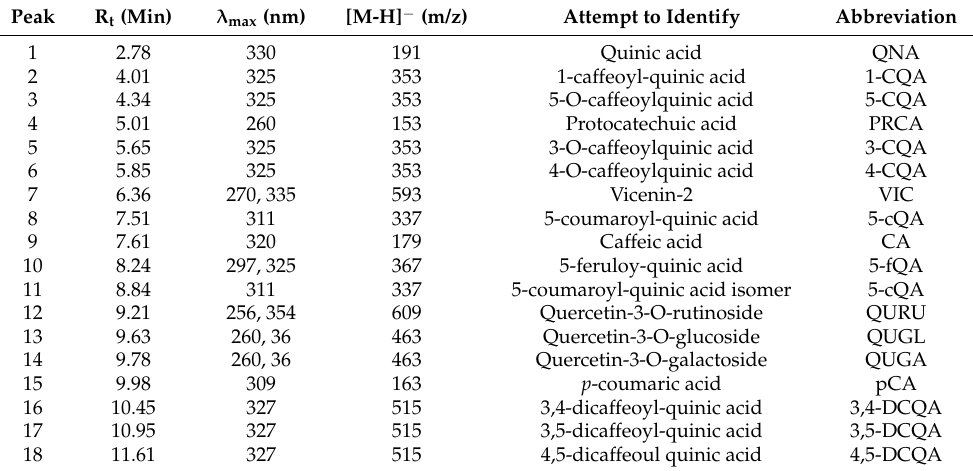
Table 3. Eighteen main phenolic compounds with their abbreviations, identified by HPLC-DAD-MS in methanolic extracts of native Greek rock samphire genotypes. Peak